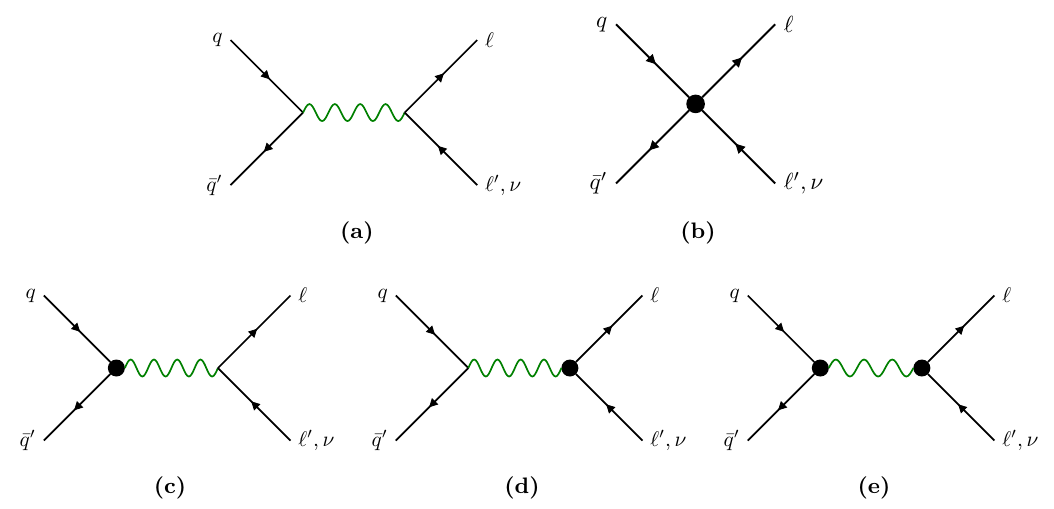
Figure 2. Feynman diagrams of the leading contributions in the SM (a) and in the SMEFT (b)- (e) to the partonic processes q ¯ q 0 → ‘‘ 0 and u ¯ d 0 → ‘ν assuming an EFT expansion up to O (1 / Λ 4 ) . The green mediator represents the exchange of the SM gauge bosons V ∈ { γ, Z, W } and the black vertices are insertions of the SMEFT effective